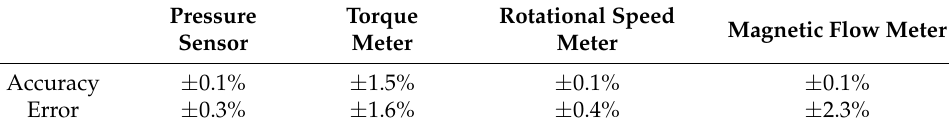
Figure 17. Schematic of ( a ) the pump test rig; ( b ) the vibration acceleration sensor. Table 4. Accuracy and calculated errors of other instruments.